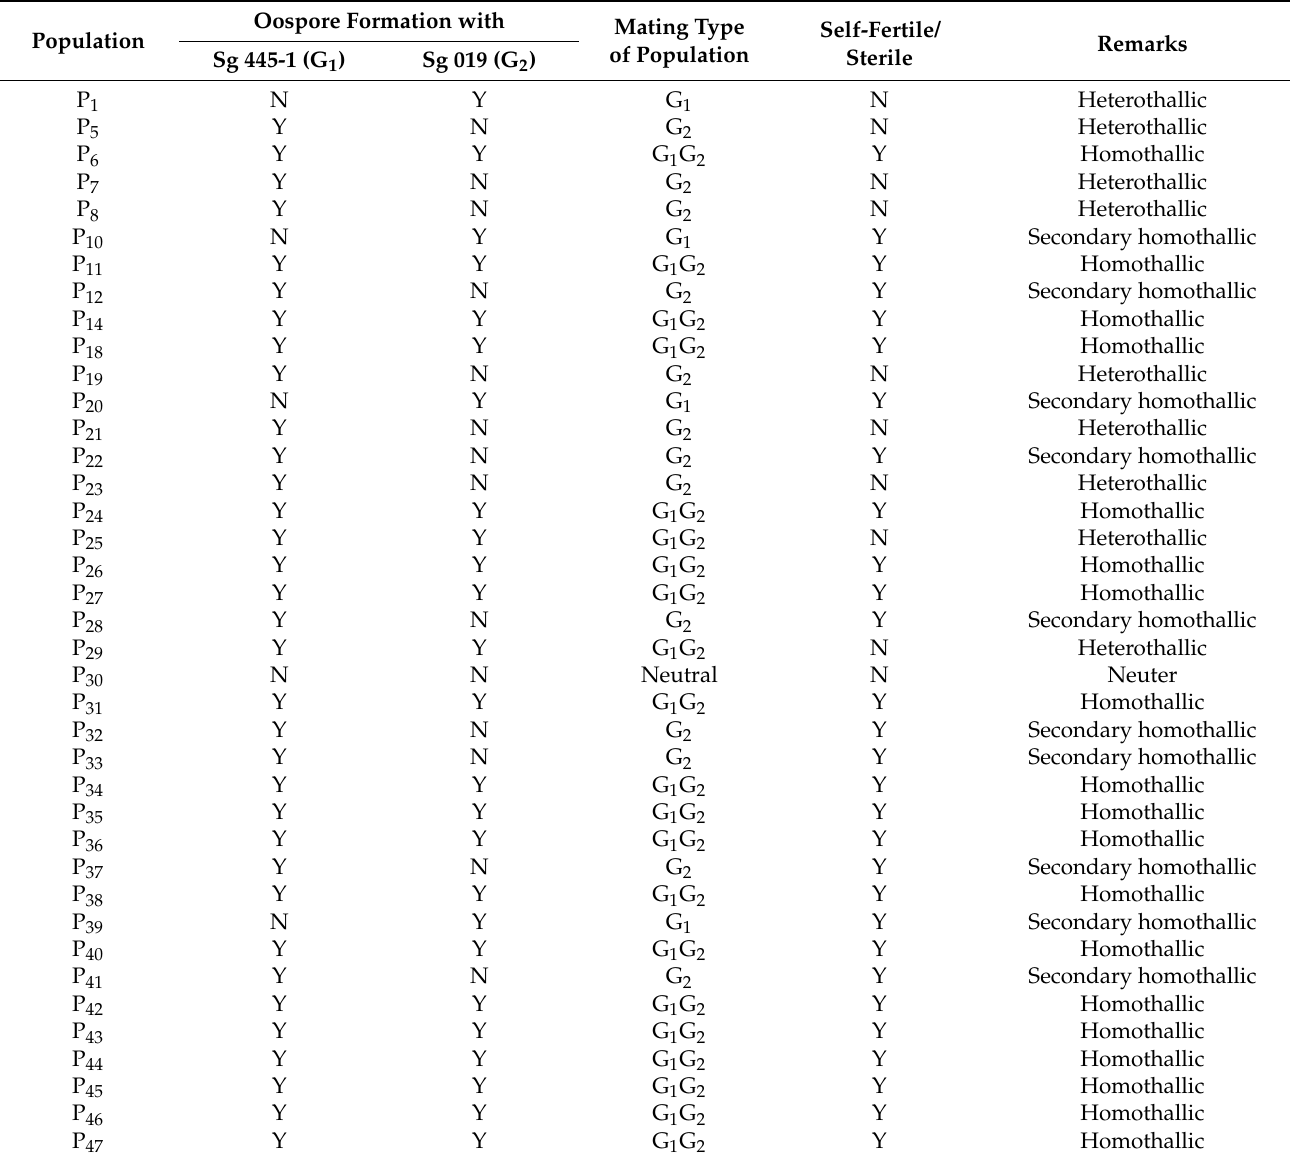
Table 4. Determination of sexual compatibility types of F 1 progenies based on oospores